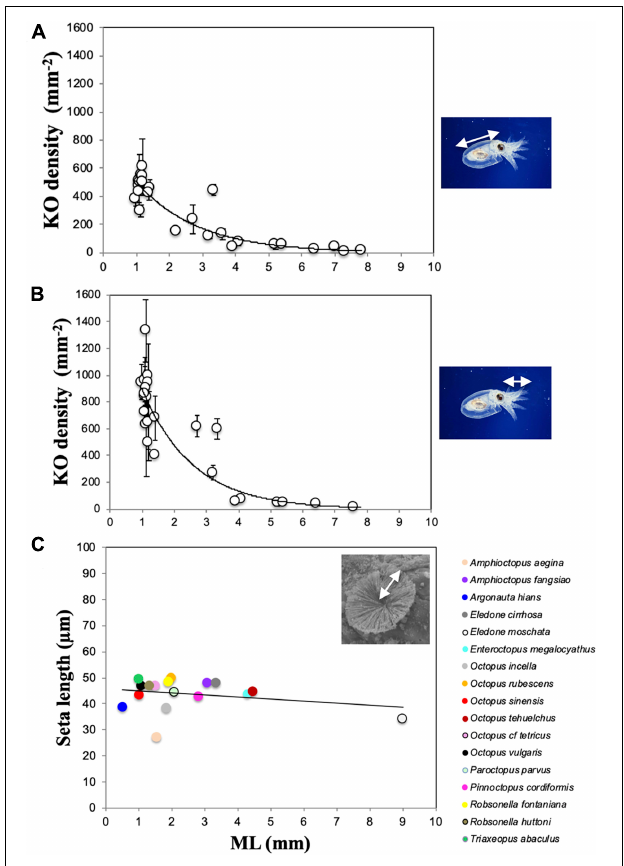
FIGURE 9 | Density of Kölliker’s organs (KO) over the mantle + head (A) and arms (B) in Octopus vulgaris individuals from planktonic hatchling to wild benthic, juvenile individuals. Line indicates exponential relationship, error bars indicate standard deviation. ML, mantle length. (C) Mean values of KO seta length (SL) related to ML in 17 species. SL for Octopus rubescens is from Brocco et al. (1974) and for Eledone moschata and Octopus cf. tetricus , SL are estimated from images of Boletzky (1973) and Joll (1978). For E. cirrhosa SL corresponds to a wild benthic juvenile of ML 23.3 mm, included here for comparison. Line indicates linear